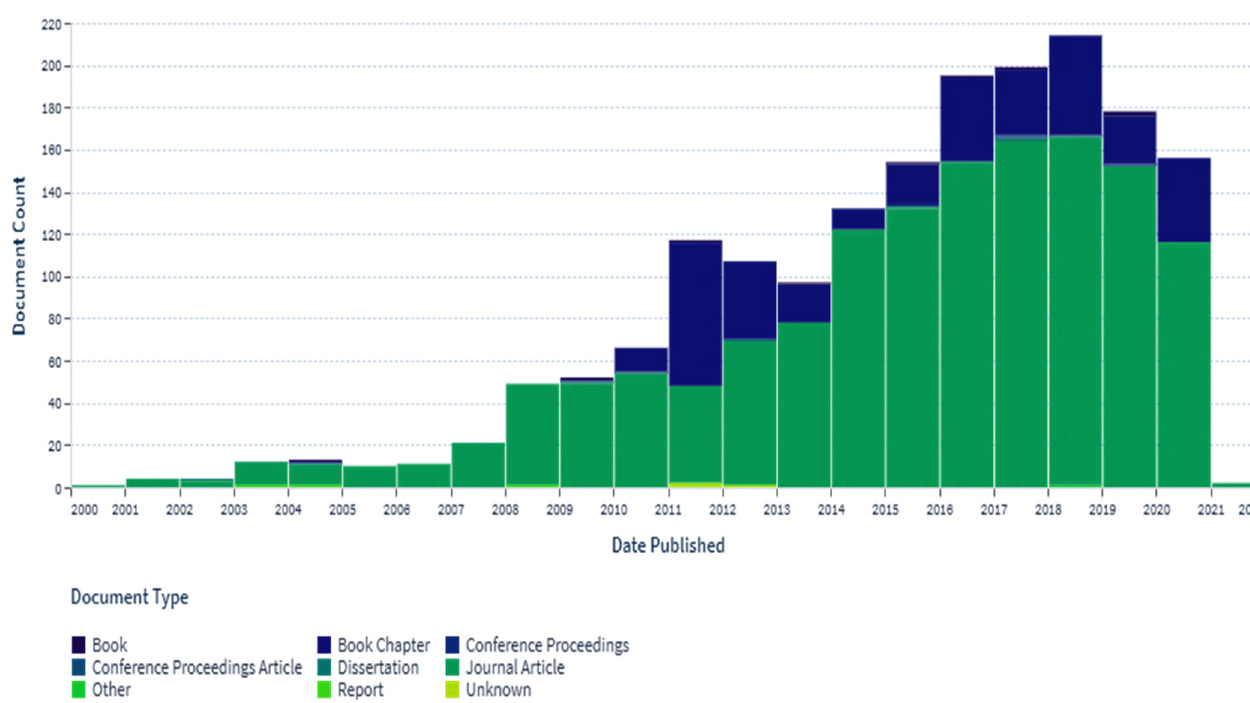
Figure 15. Number of articles published per year.